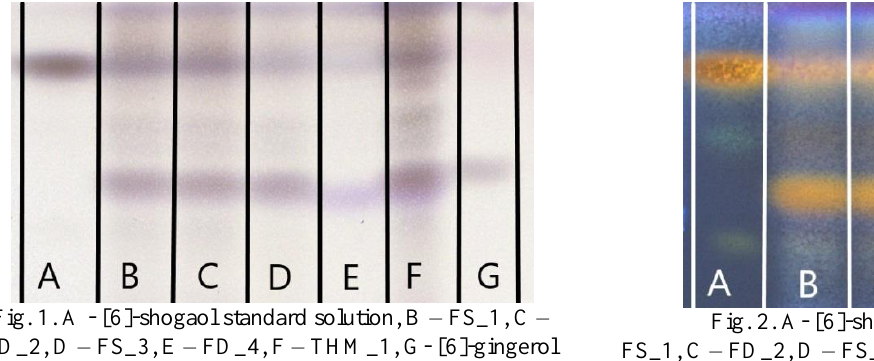
Fig. 2. A- [6]-shogaol standard solution, B – FS_1, C – FD_2, D – FS_3, E – FD_4, F – THM_1, G- [6]-gingerol standard solution.